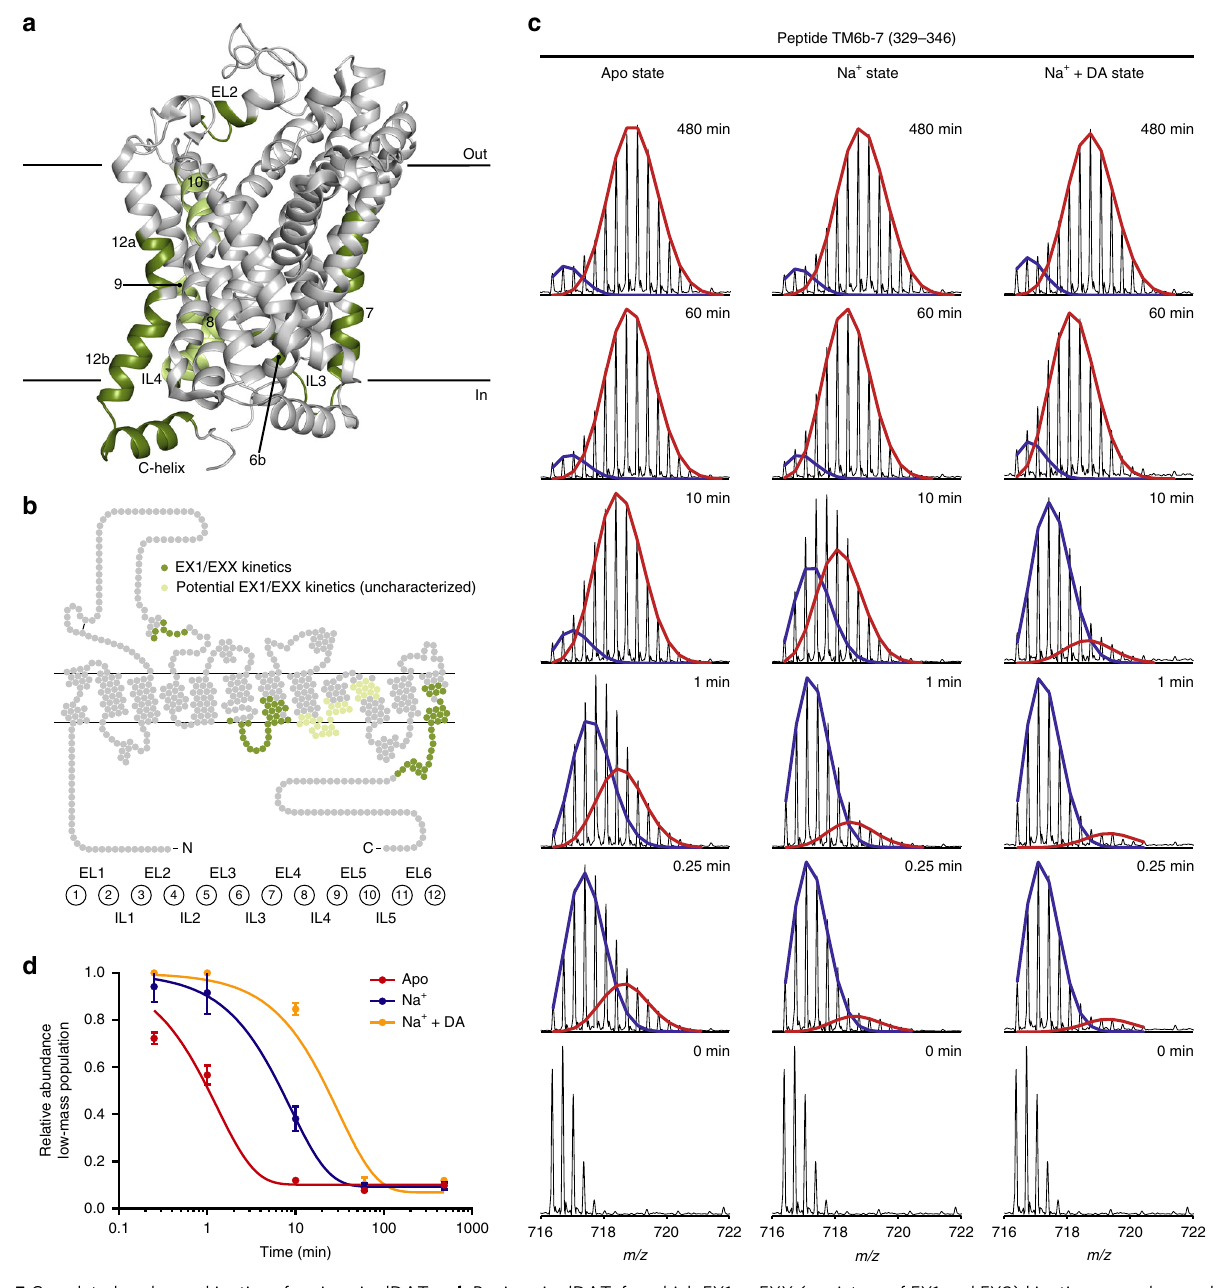
Fig. 5 Correlated exchange kinetics of regions in dDAT. a , b Regions in dDAT, for which EX1 or EXX (a mixture of EX1 and EX2) kinetics were observed, are marked in dark green on the crystal structure ( a ) (PDB ID: 4XP1) and snake diagram ( b ) of dDAT. Signs of EX1/EXX kinetics were observed in regions marked in light green, but these could not be reliably analyzed. c Representative mass spectra for peptide 329 – 346, which covers TM6b-IL3-TM7, are shown for the three states at all sampled time points. Two binomial isotopic envelopes produced the best fi t to the spectra — yielding a low- (blue) and high-mass (red) population. The rate of translation from the low-mass population to the high-mass population (i.e., k op ) was reduced upon binding of Na + relative to the apo state — and even more so by binding of Na + and DA combined. d The average relative abundance of the low-mass population is plotted against labeling time for the three states shown in c . Error bars indicate standard deviations ( n = 3 for all time points for the apo state and the Na + - and DA-bound state, n = 6 for all time points for the Na + -bound state). The data were fi tted to an exponential decay function. Data from overlapping peptides yielded similar results (Supplementary Fig. 5b, Table 1). Source data are provided as a Source Data fi